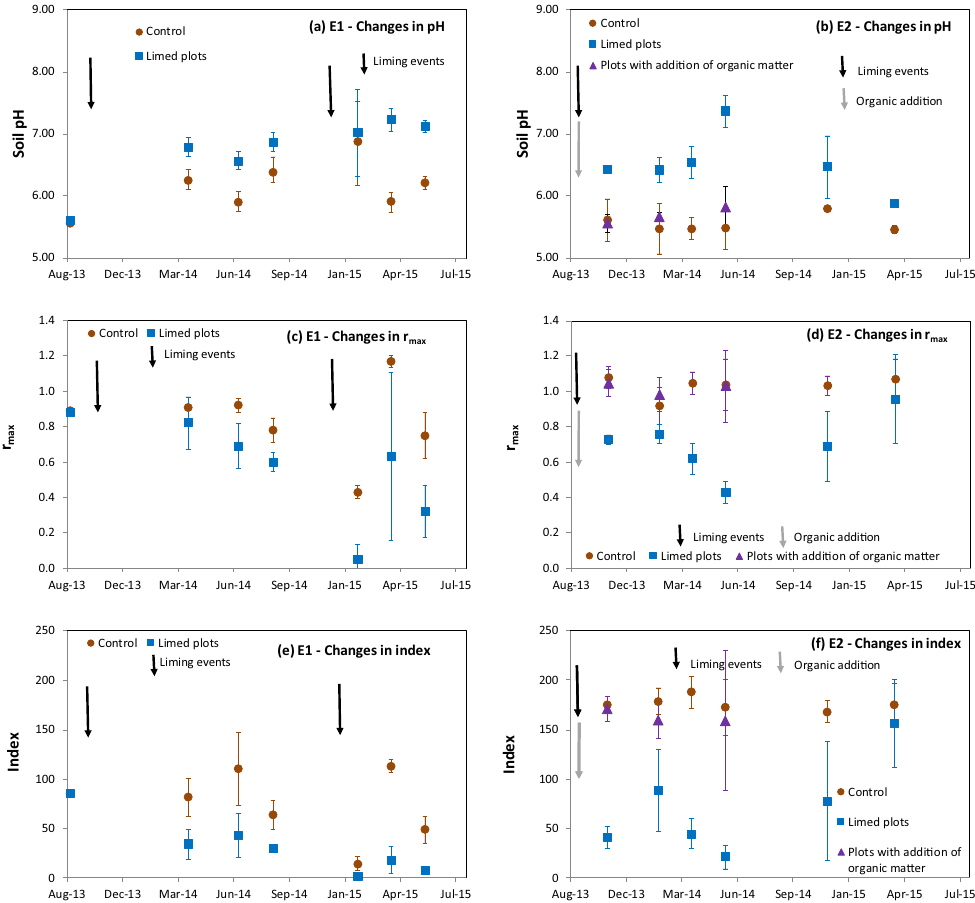
Figure 4. Changes in the indicators (pH, r max and index) of the capacity of soil to reduce N 2 O during E1 (left) and E2 (right). Error bars represent standard deviations (n =